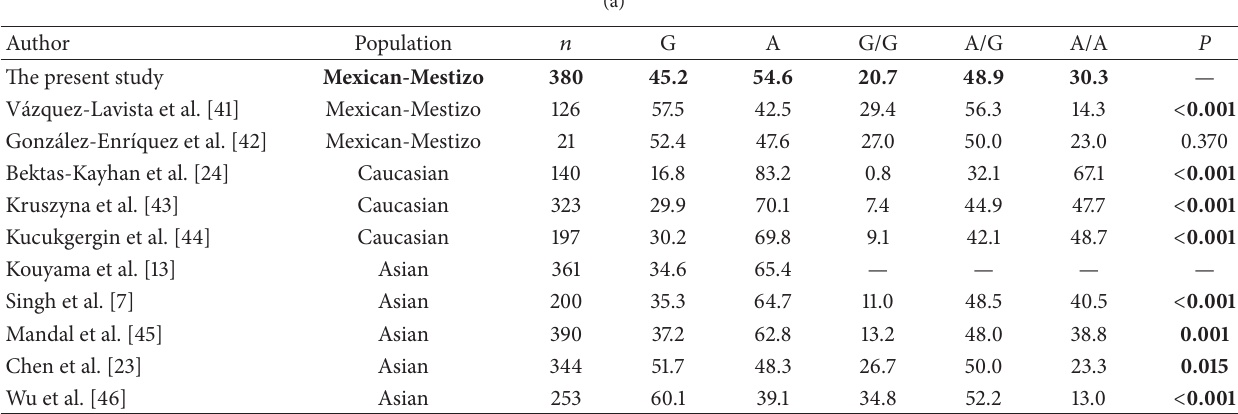
Table 5: (a) Distribution of G-2518A polymorphism in CCL2 gene in other populations. (b) Distribution of Val64Ile polymorphism in CCR2 gene in other